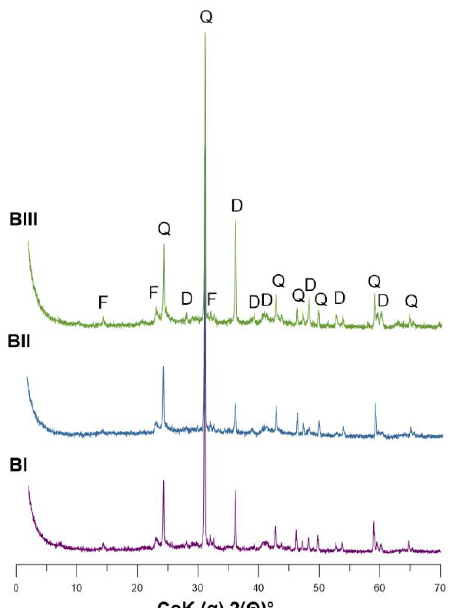
Figure 1. X-ray diffraction patterns for BI, BII, and BIII samples. Q—Quartz, D—Dolomite, F— Figure 1. X-ray di ff raction patterns for BI, BII, and BIII samples. Q—Quartz, D—Dolomite, Feldspar.